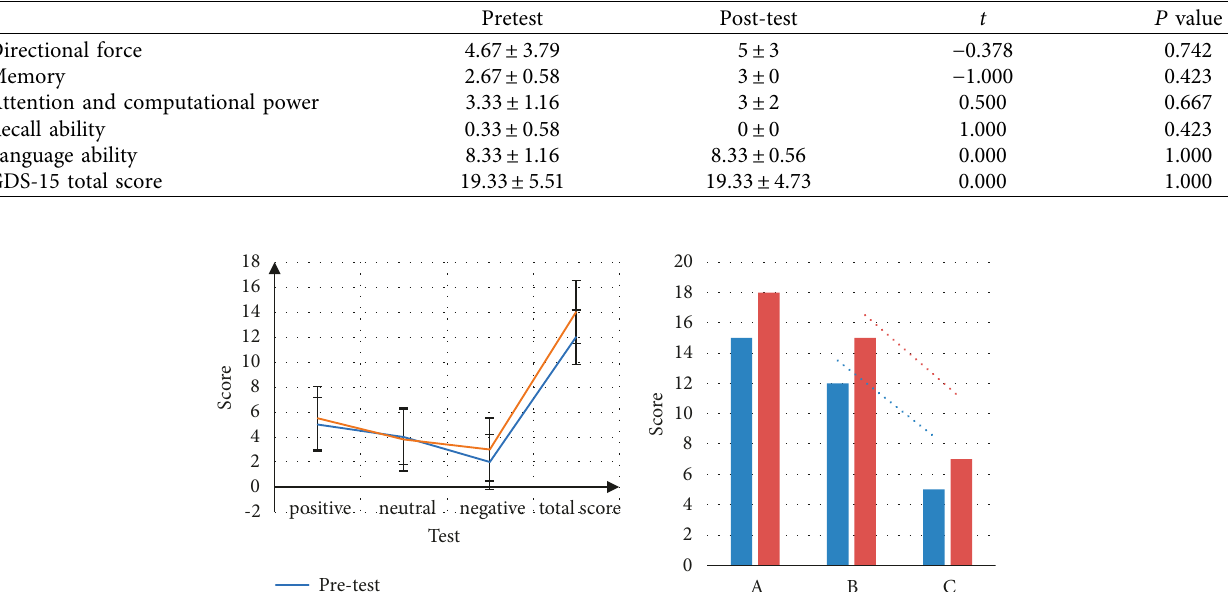
Table 4: Comparison of scores between groups before and after GDS-15 treatment.